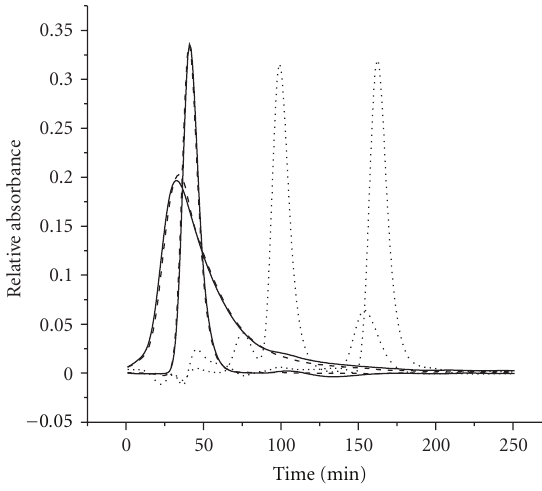
Figure 3: Normalized chromatographic profiles were resolved by the SWATLD in human plasma. Solid and dotted lines represent the chromatographic profiles of vancomycin, cephalexin, and interfer- ence. The medium dash denotes the actual vancomycin and cepha-